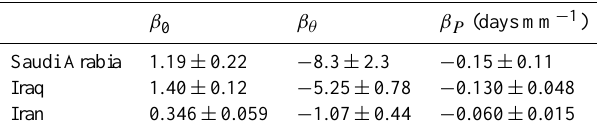
Table 2. Regression coefficients for the linear AOD model and their standard